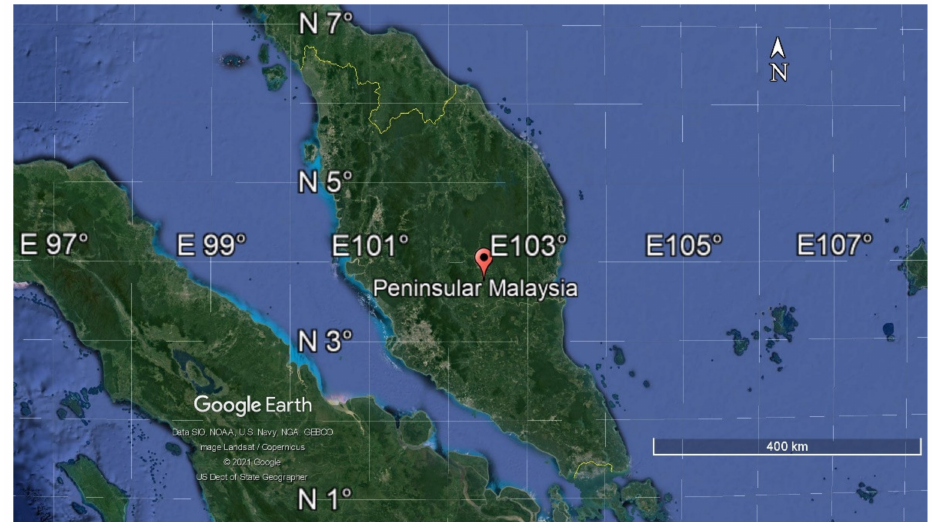
Figure 1. Map of Peninsular Malaysia. (Source: Map Data © 2021 Google Imagery © 2021 Land-